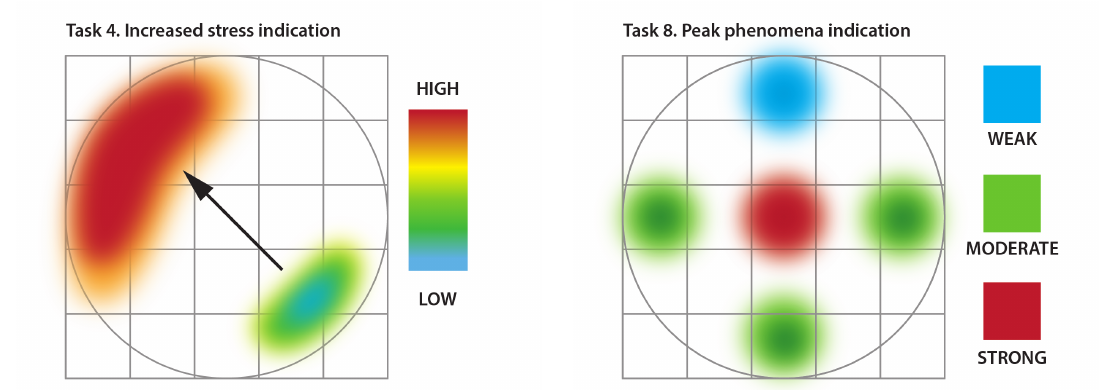
Figure 12. Heatmap illustrations for exemplary drawing tasks plotted on a background grid corresponding to the cross-sectional area of the measurement space. ( Left ) Stress indication, Task no.4 (dark red for maximum, blue for minimum. The arrow points toward the maximum values). ( Right ) Peak indication, Task no.8. (Dark red in the center for strong, light blue in top for weak, and green for